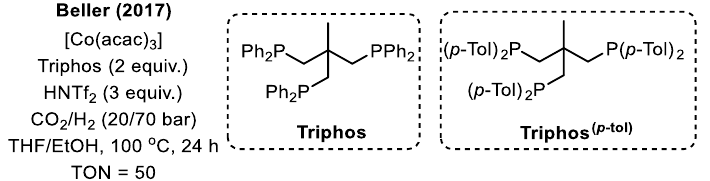
Figure 13. The non-noble cobalt catalysts for direct CO 2 hydrogenation.